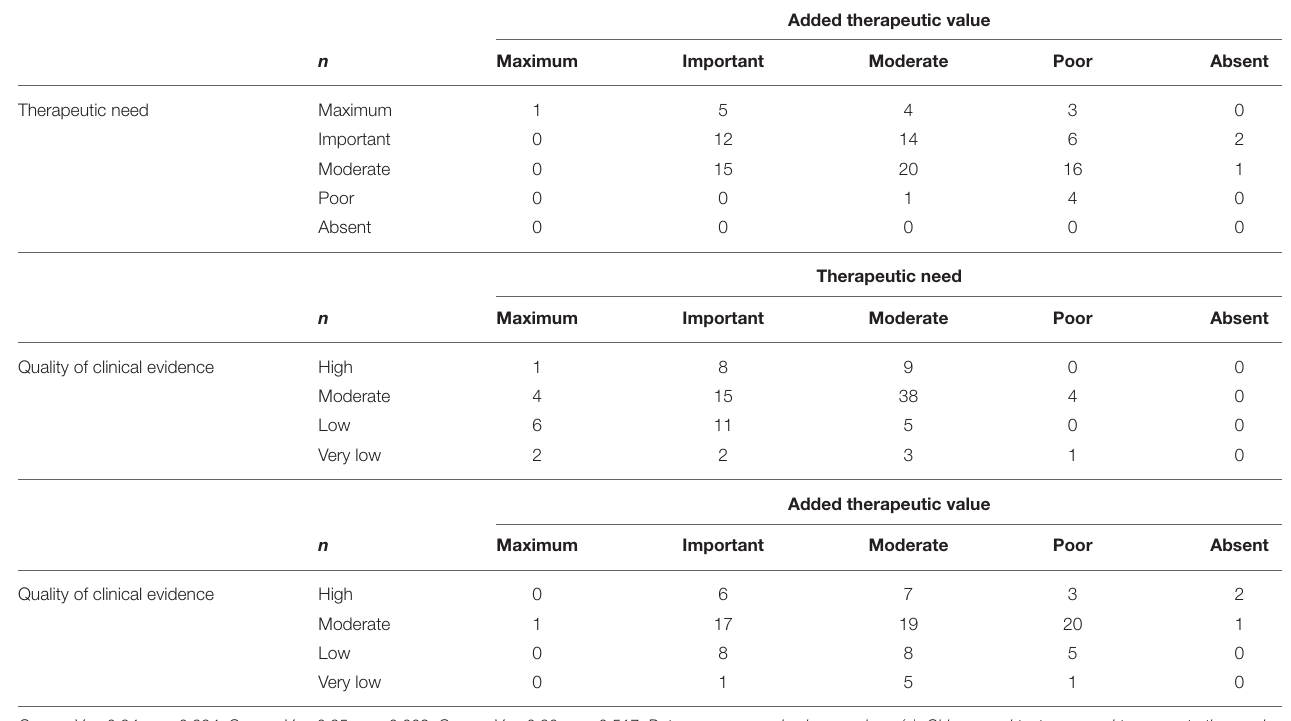
TABLE 2 | Relationship between criteria utilized in the multidimensional approach in defining innovativeness of a new